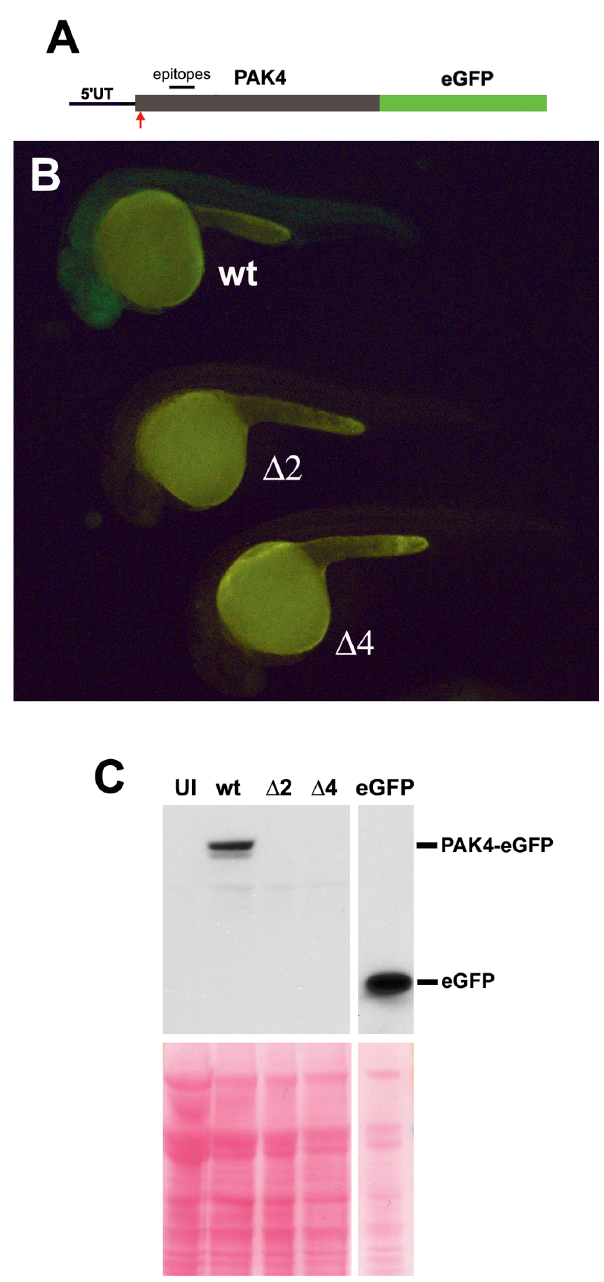
Figure 4. Testing for possible alternative translational initia- tion downstream from the mutation site. (A) Construction of the PAK4-GFP fusions. The 5 9 -UTR and open reading frame of pak4 were cloned upstream of an eGFP cassette. The TALEN mutation site is indicated by the red arrow. (B) Expression of the fusions in zebrafish embryos. PAK4-eGFP RNAs were synthesized by in vitro transcription and injected into one-cell stage embryos. Green fluorescence was monitored at 24 hpf. Only the wild type construct exhibited fluores- cence. (C) Western blot analysis of PAK4-eGFP RNA-injected embryos. Embryos at 24 hpf were dechorionated and used for total protein extraction and Western analysis with a GFP-specific antibody. eGFP RNA was injected into embryos as a positive control. UI, uninjected wild type EK. wt, wild type PAK4-eGFP. D 2, PAK4 D 2-eGFP. D 4, PAK4 D 4-eGFP. Ponceau Red staining of the Western blot membrane is shown as a loading control.